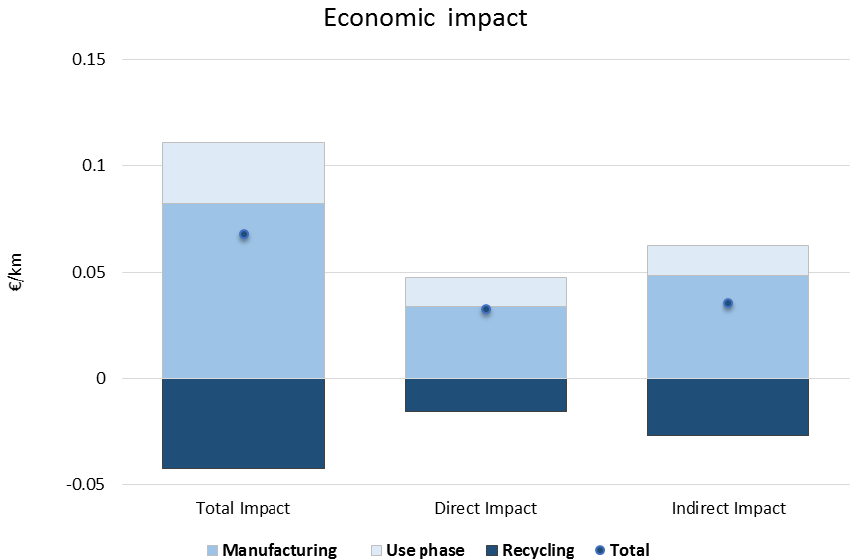
Figure 8. Impact on the production of goods and services during the life cycle of the Energy Storage System in €/km.